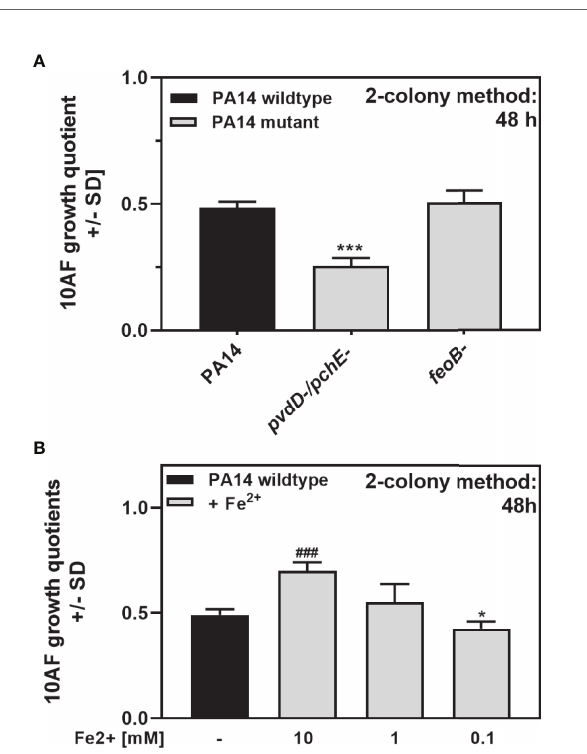
FIGURE 10 | Antifungal activity of P. aeruginosa in response to ferrous iron. (A) Six-millimeter paper disks were placed on RPMI agar. Ten microliters of A. fumigatus 10AF conidia (10 7 /ml, prepared in RPMI) was placed on each disk, and 10 µl of PA14 wild-type, PA14 pvdD-/pchE- , or PA14 feoB- bacteria (10 9 /ml, prepared in RPMI) was placed 15 mm distant from the disks carrying 10AF. Plates were incubated for 48 h at 37°C, and growth quotients were determined. Comparison: PA14 (black bars) vs . all other bars in the same group. (B) Six-millimeter paper disks were placed on RPMI agar. Ten microliters of A. fumigatus 10AF conidia (10 7 /ml, prepared in RPMI) was placed on each disk, and 10 µl offerrous iron was added to the fi lter disks at 10, 1, or 0.1 mM. Plates were incubated at 37°C for 48 h, and fungal growth areas were determined. Comparison: PA14 without iron addition (black bar) vs . all other bars. Statistical analysis in (A, B) , t-test: one or three asterisks or pound signs = p ≤ 0.05 and p ≤ 0.001, respectively. Asterisks represent signi fi cant increases in antifungal activity; pound signs represent signi fi cant